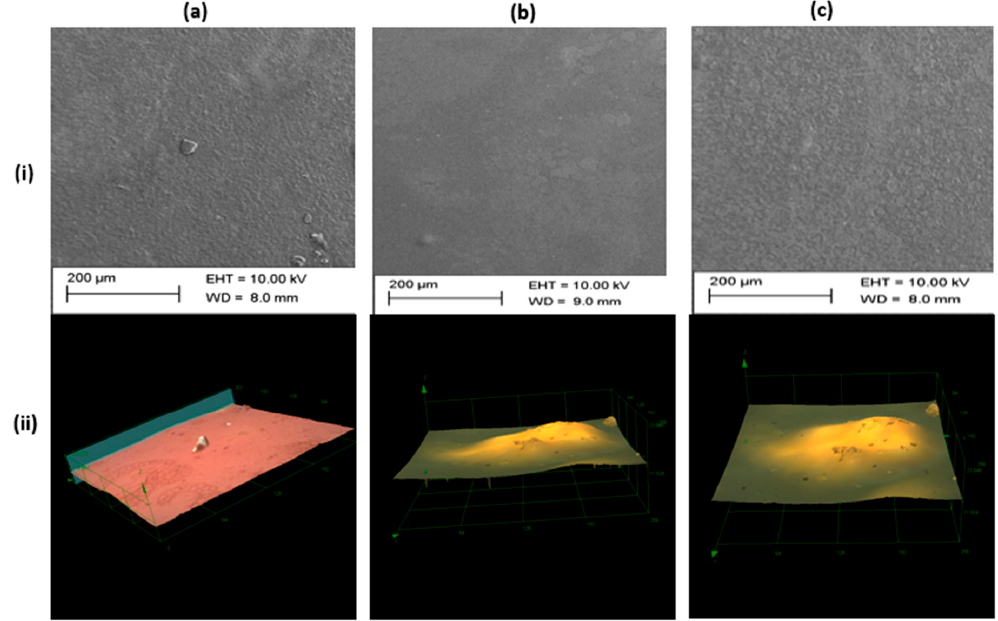
Figure 2. Scanning electron micrographs ( i ) and 3D scanning laser confocal microscopy images ( ii ) for three representative curcumin inserts F1 ( a ), F5 ( b ) and F7 ( c ). The confocal microscope images show views of size 256 × 256 µm from left to